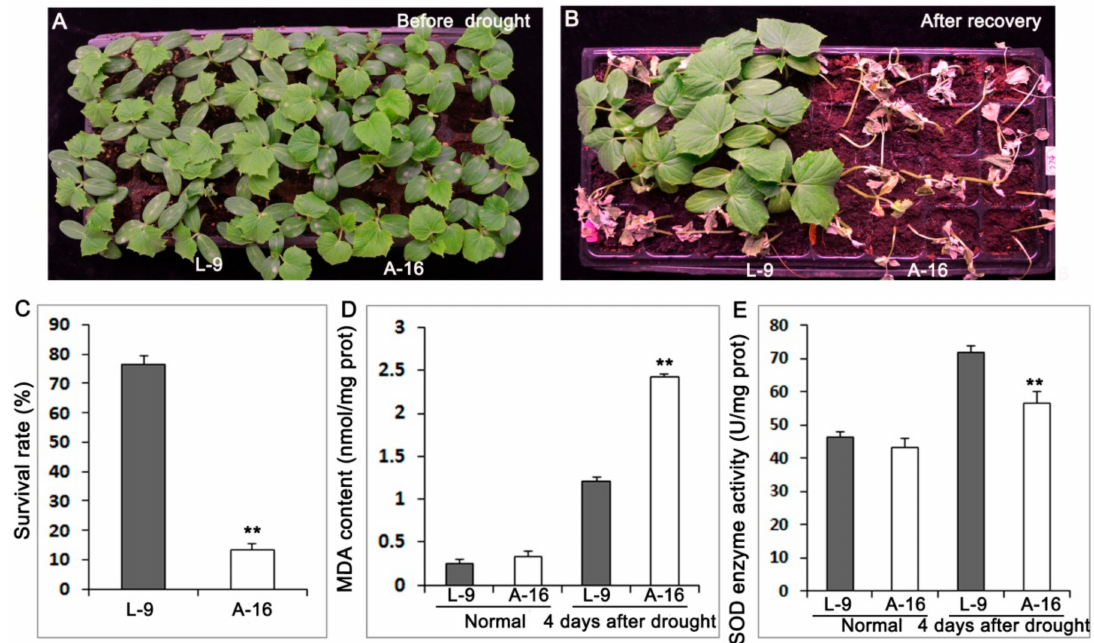
Figure 1. Phenotypes of L-9 and A-16 before drought and after recovery of drought stress. ( A ) L-9 and A-16 plants were grown under normal conditions for 14 days. ( B ) After 7 days drought treatment, seedlings recovered for 3 days. ( C ) Survival rate of plants following the 7-day drought treatment. ( D , E ) Measurement of MDA content ( D ) and SOD enzyme activity ( E ) under normal conditions and 4 days after drought. Data is presented as the mean ± standard deviation ( n = 9). ** p < 0.01; Student’s t